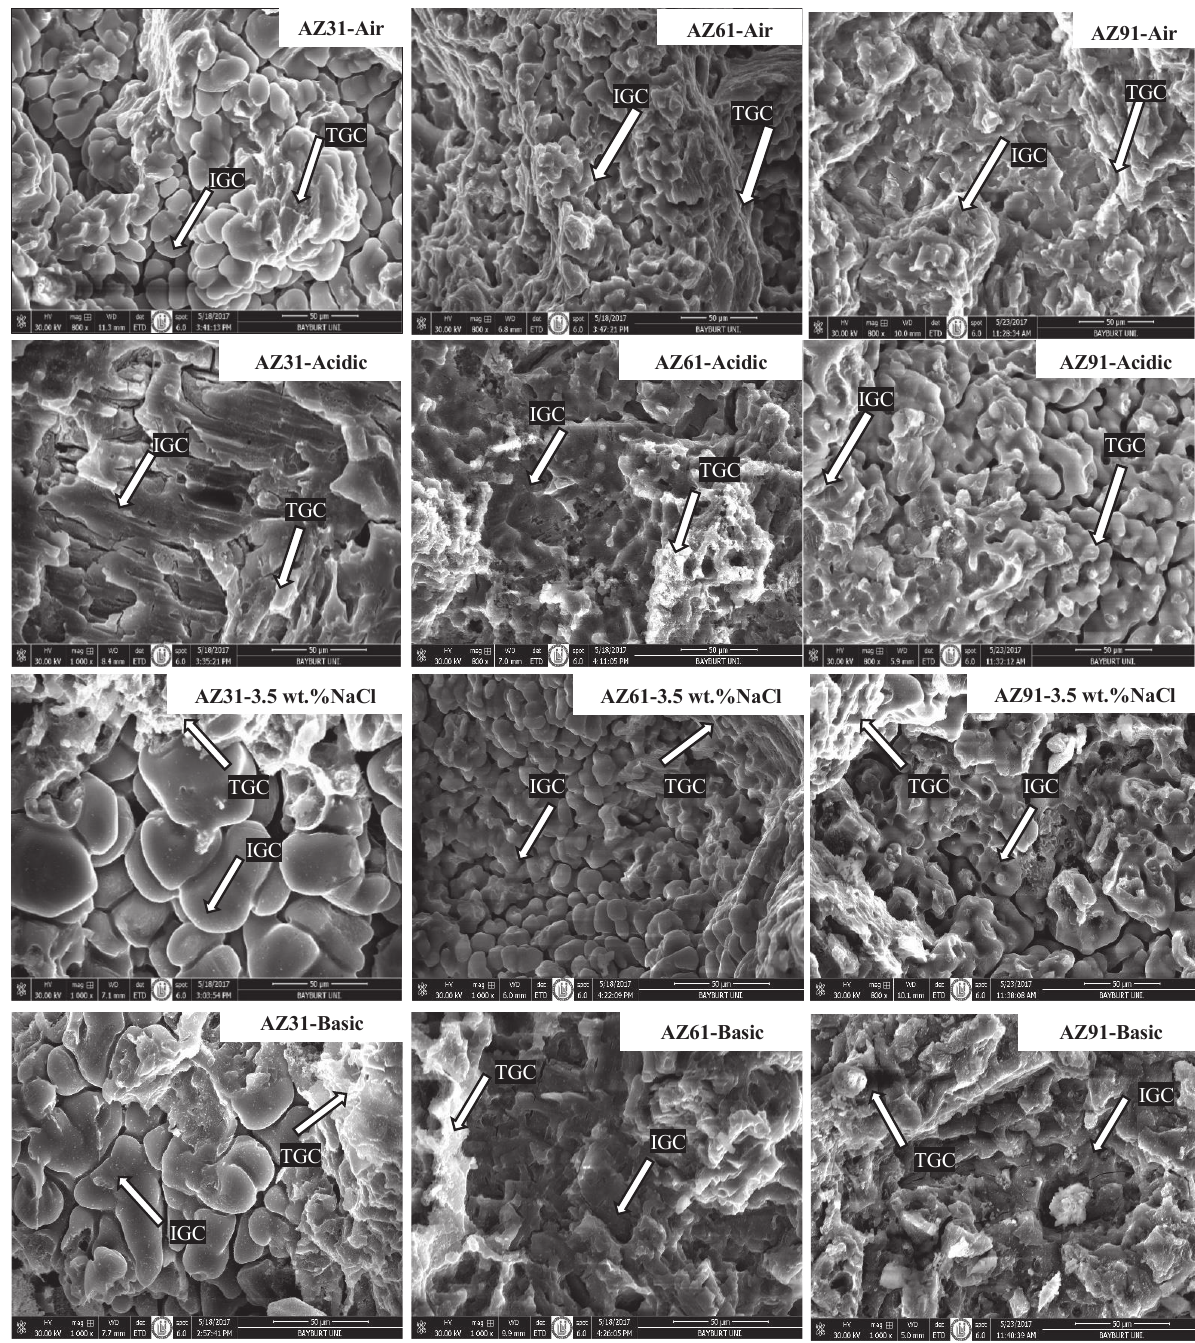
Figure 6: SEM images of the fracture surfaces in different media for AZ31, AZ61 and AZ91 Mg alloys.